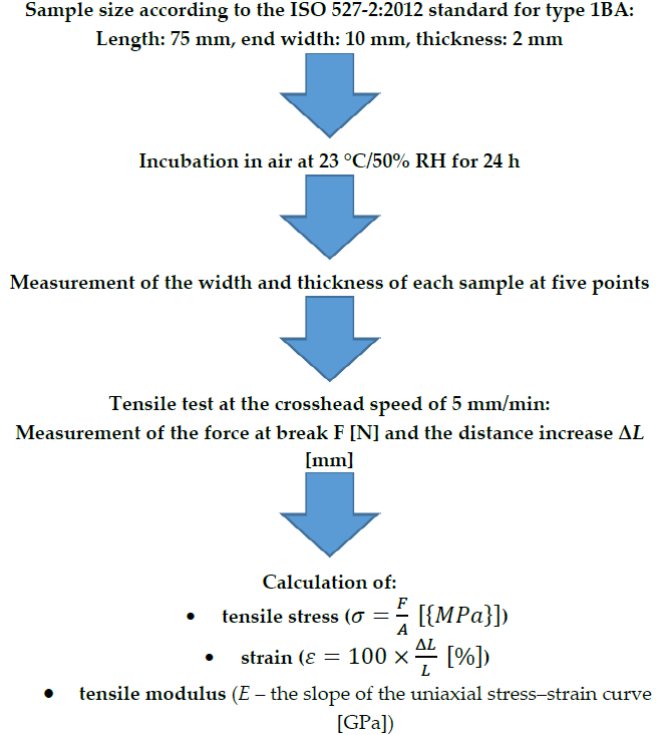
Figure 3. Tensile test according to the PN-EN ISO 527-1: 2019 ( E ) standard ( F , force (N), A , initial cross-sectional area measurement (mm 2 ); L , measurement of the distance between the grips (mm); ∆ L , increase in distance between the grips (mm)).